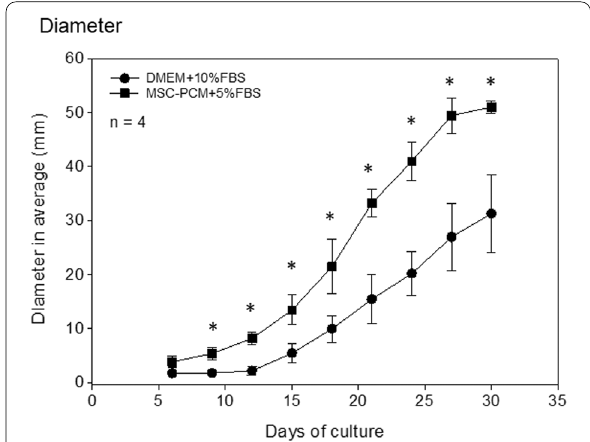
Fig. 3 Time-course changes in the diameter on of the average, that is two-dimensional growth of periosteal sheets. n DMEM 10%FBS at the same +